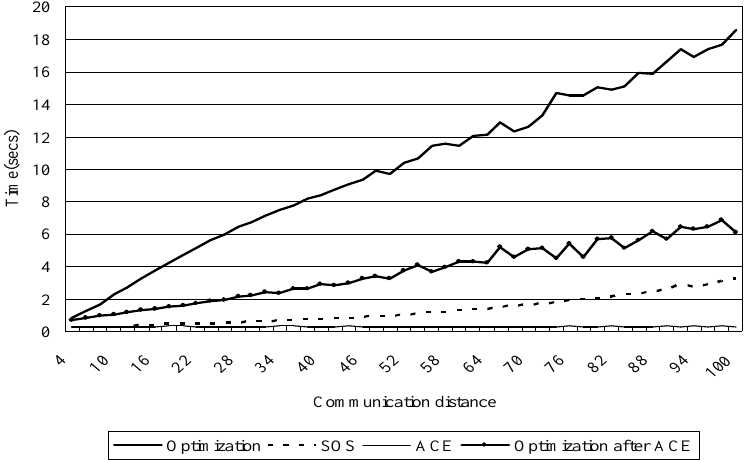
Figure 11. Comparison of execution